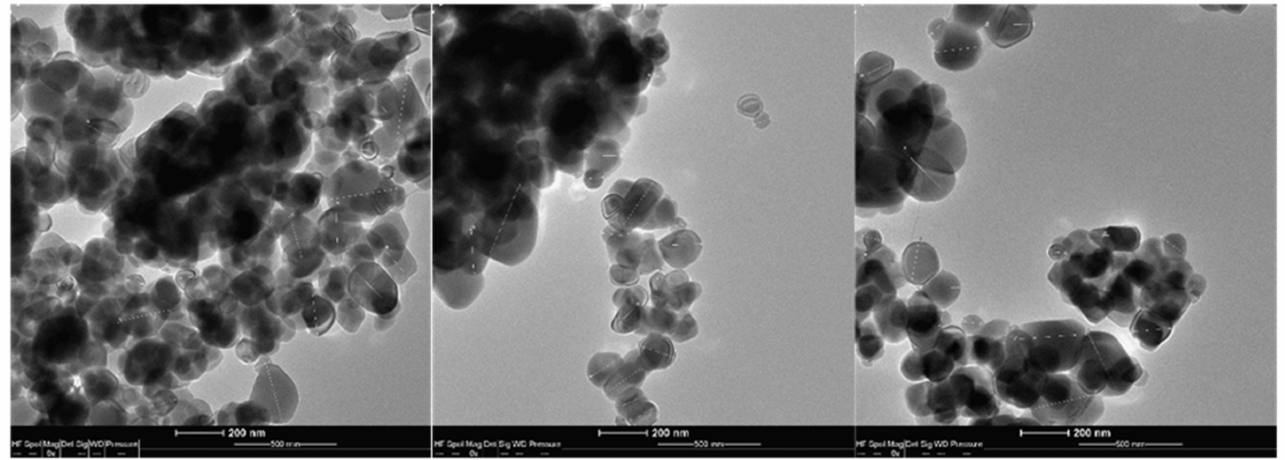
Figure 1. TEM images of the analyzed TiO 2